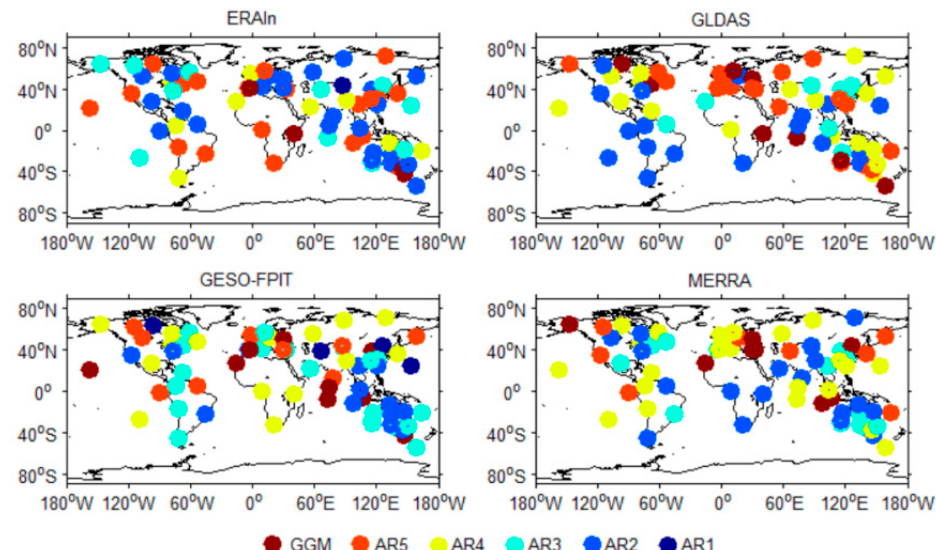
Figure 4. Noise model scatter of the four hydrology loading predictions at 70 GPS stations for the up component with the lowest Akaike Information Criterion (AIC). AR( p ) = autoregressive noise with an order of p , and GGM = Generalized Gauss Markov noise.